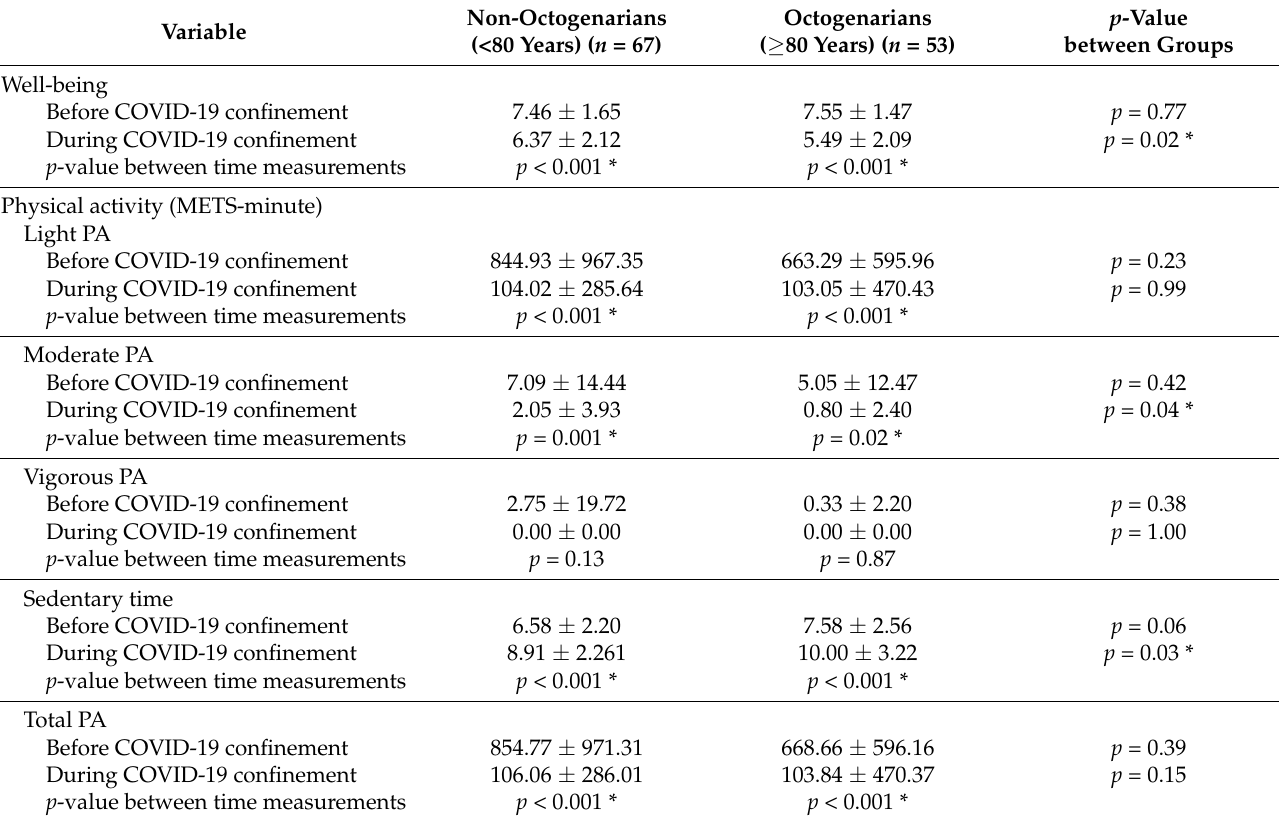
Table 4. Well-being and physical activity of octogenarians vs. non-octogenarians HF patients before and during COVID-19